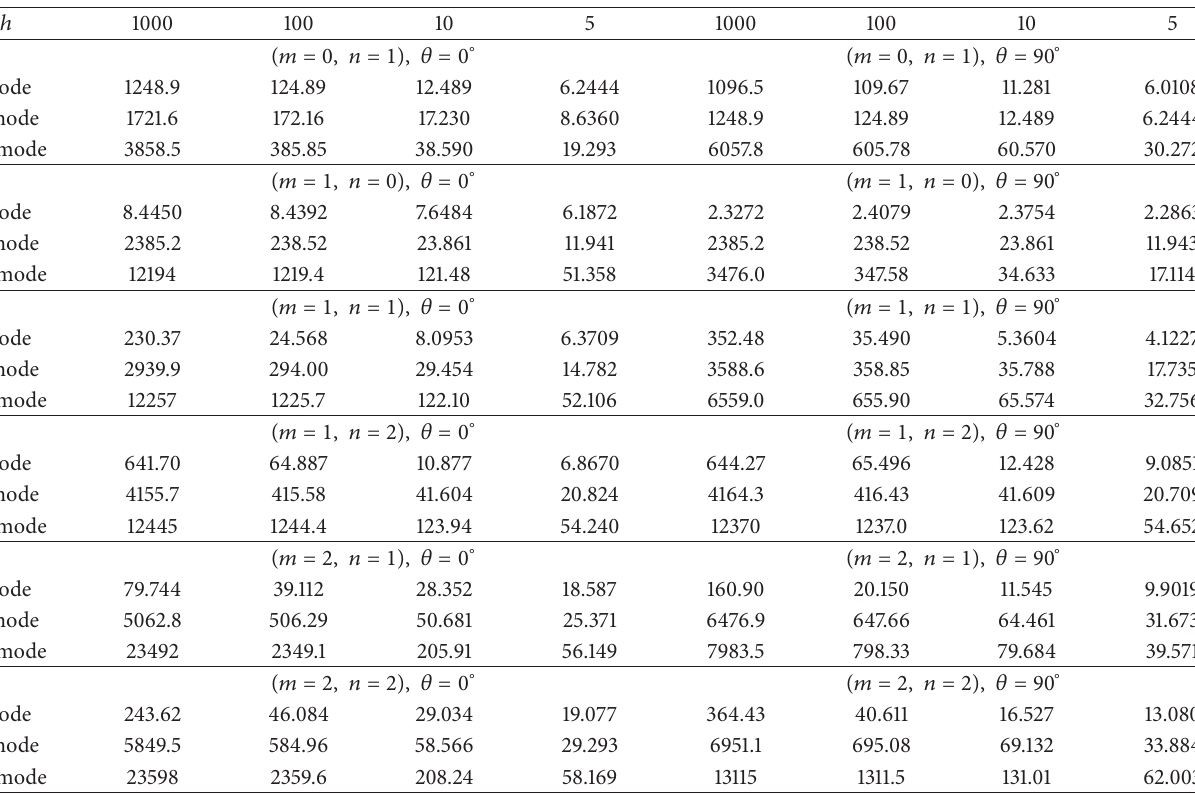
Table 10: Benchmark 6. Simply supported orthotropic cylindrical shell panel. First three vibration modes in term of no-dimensional circular frequency 𝜔 = 𝜔(𝑎 2 /ℎ)√𝜌/𝐸 2 forseveralcombinationsofhalf-wavenumbers 𝑚 and 𝑛 . 𝑀 = 100 fictitiouslayersand 𝑁 = 3 orderofexpansion for the exponential matrix.